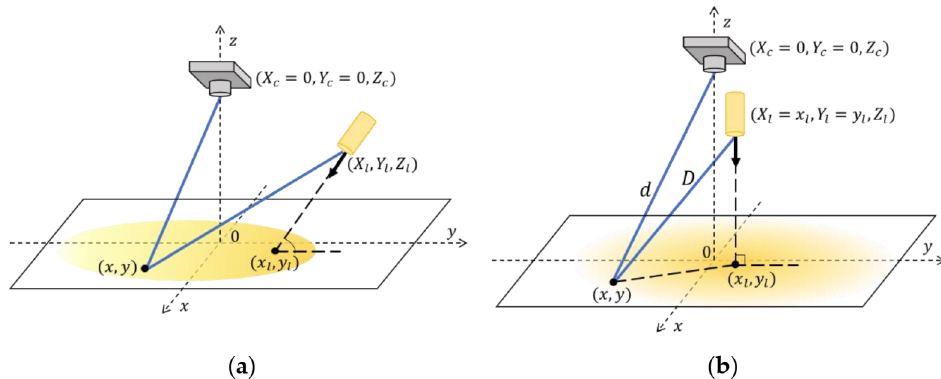
Figure 3. The difference of arbitrary and fixed light modes. ( a ) Diagram of artificial lighting with arbitrary orientation. ( b ) Diagram of artificial lighting with orthographic orientation. In the dia- grams, ( X l , Y l , Z l ) represents the location of light source, ( x l , y l ) represents the project of light center, ( X c , Y c , Z c ) is the location of camera, ( x , y ) is the location of a photographed scene point, d represents the distance from scene point to camera, D is the distance from scene point to light